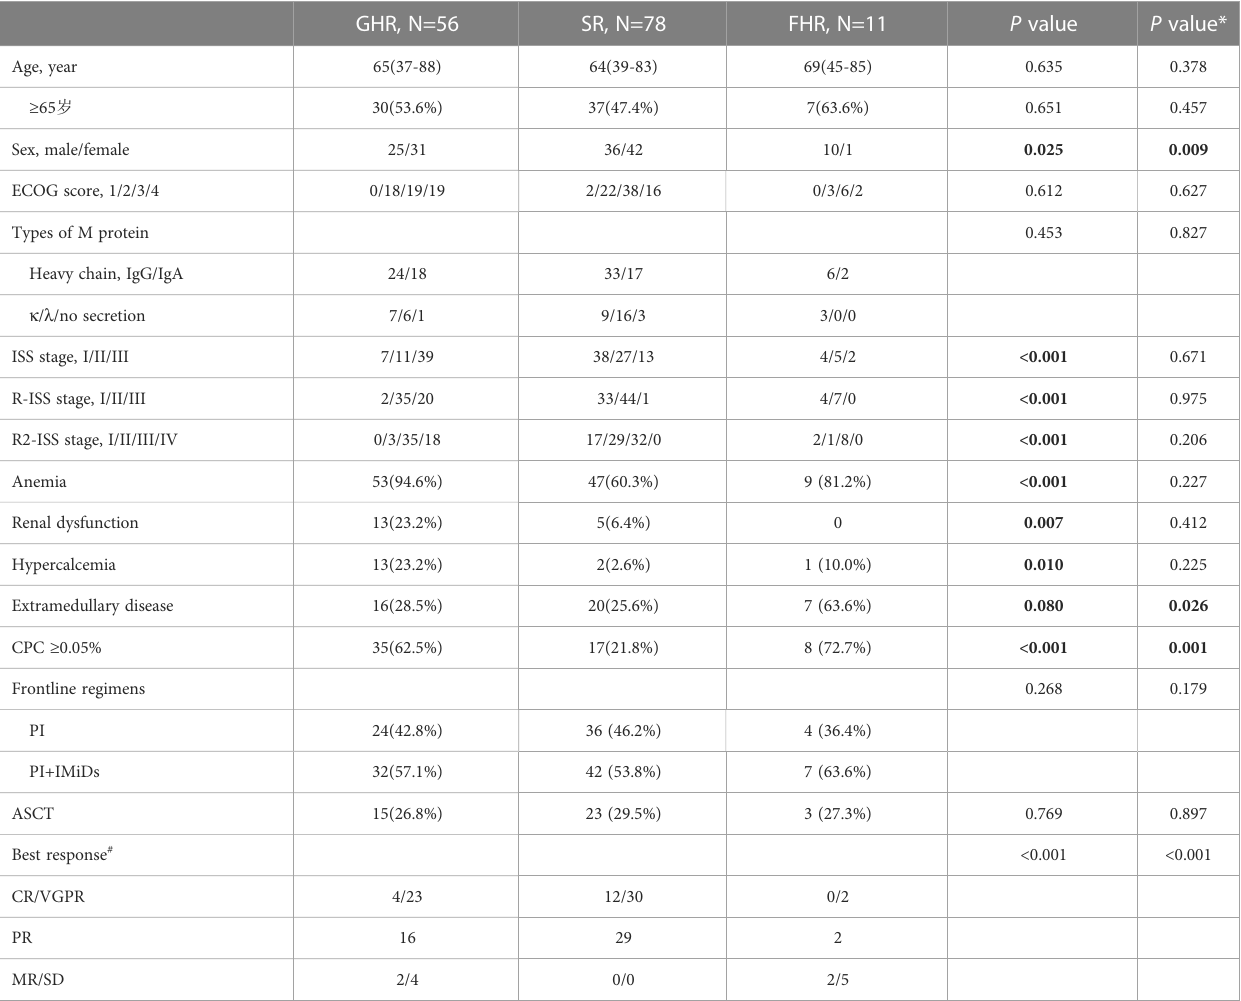
TABLE 1 Baseline